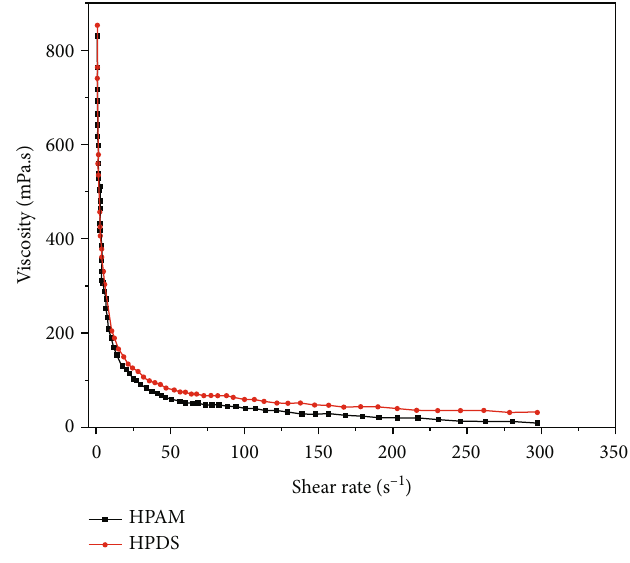
/ c or ln η / c and relative viscosity. r r sp r